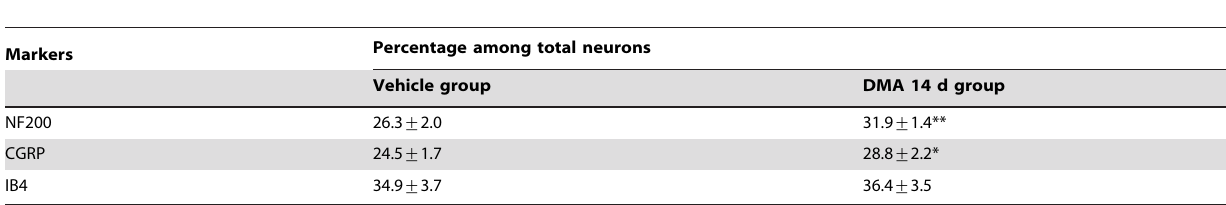
Table 1. Percentage of NF200-, IB4- and CGRP-IR neurons in vehicle-treated and DMA 14 d groups (n=4–6).